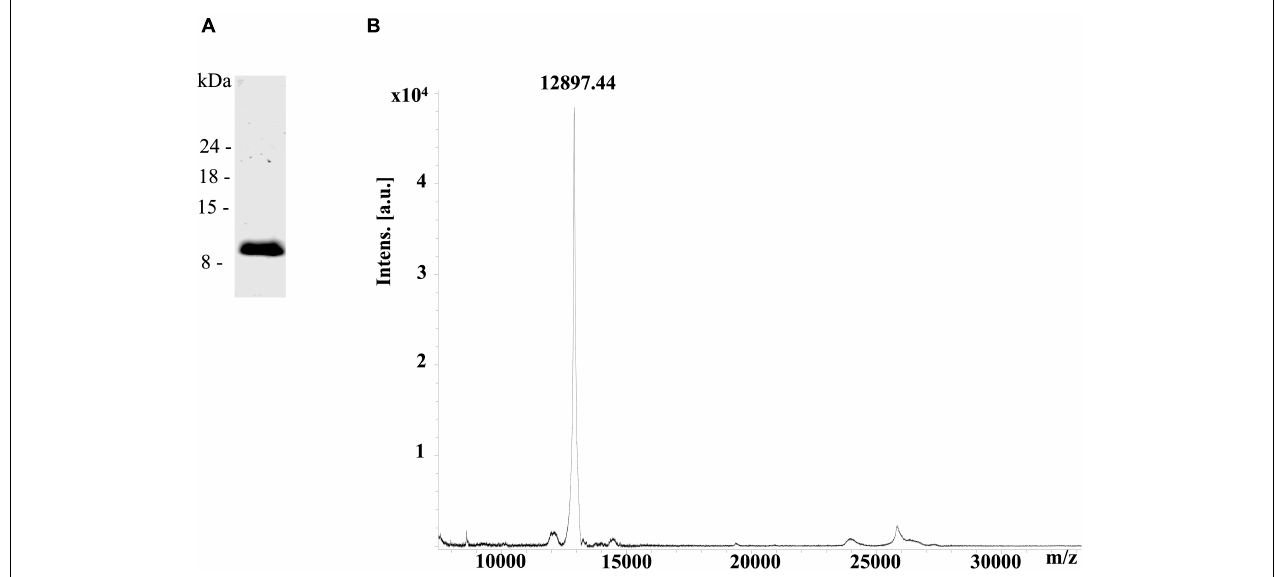
FIGURE 1 | Overexpression of recombinant domain III (rDIII). (A) LDS-PAGE showing a single protein band of purified rDIII at ∼ 12 kDa. (B) The protein mass spectrum of rDIII showed a single peak at 12.8 kDa on MALDI-TOF MS.